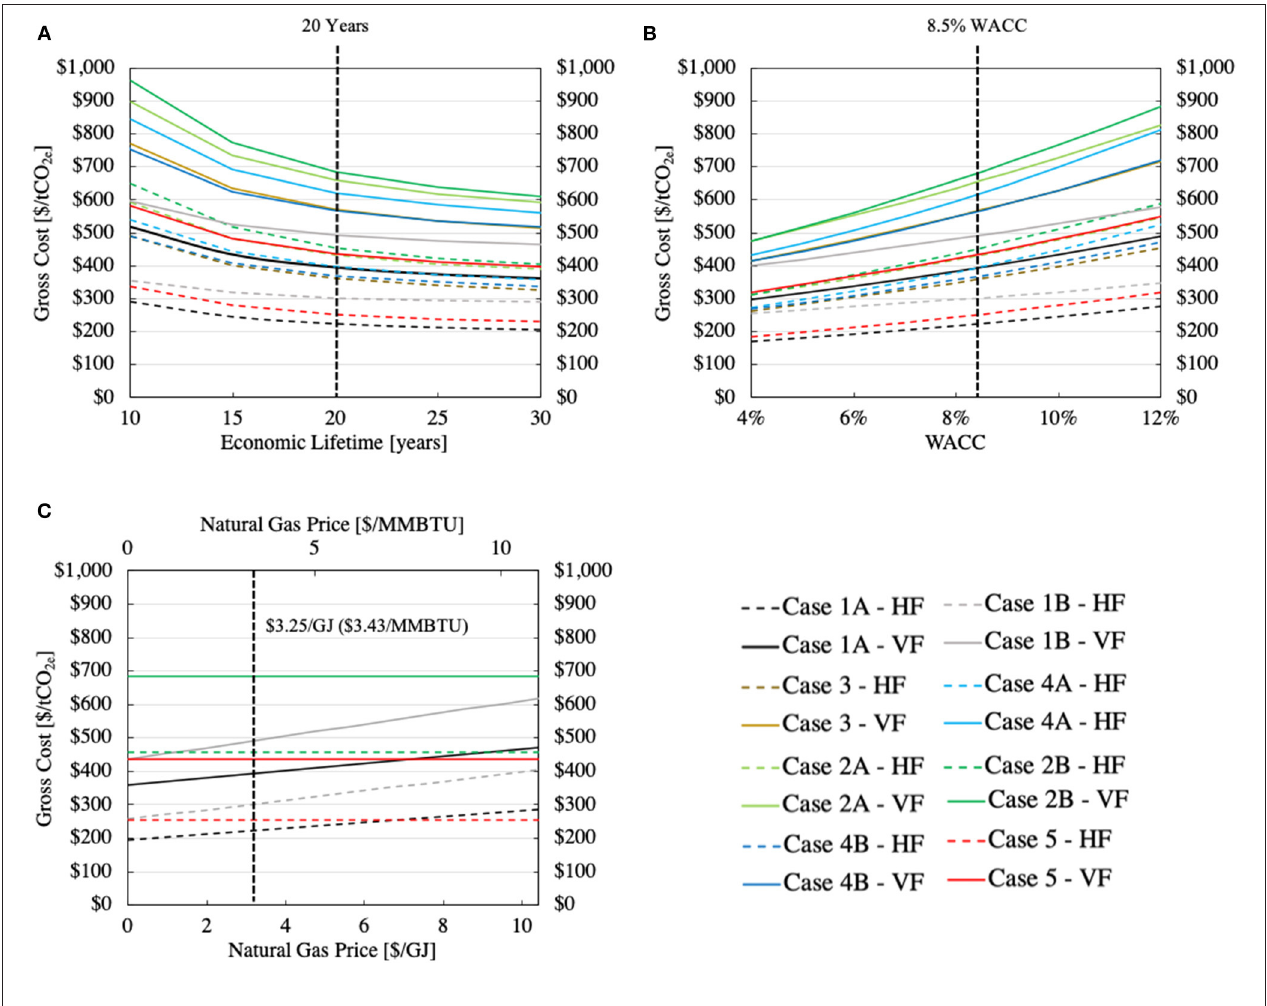
FIGURE 9 | Sensitivity of the gross removed costs for all the considered alternative energy systems when just one parameter is varied: (A) the plant’s economic lifetime (B) the weighted average capital cost (WACC) and (C) cost of natural gas. When a parameter is not varied it is fixed at 20 years for the economic lifetime, 8.5% for the WACC, and $3.25/GJ ($3.43/MMBtu) for the natural gas price. The vertical dotted black lines indicate these values when the parameter is varied. In (C) , only two of the six non-fossil cases (2B and 5) are plotted to simplify the figure: all non-fossil options produce horizontal